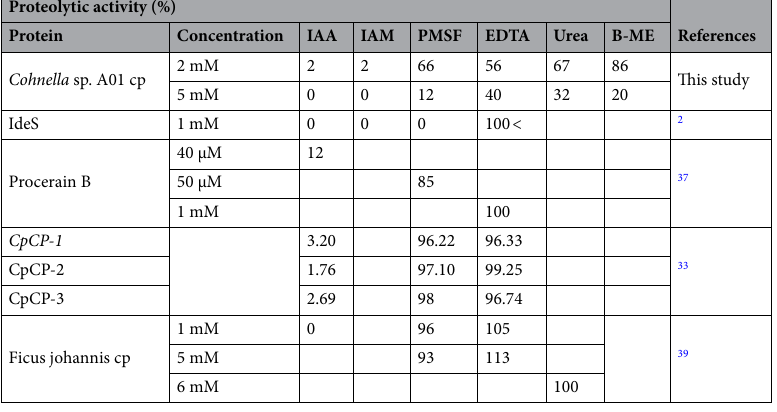
Table 3. Effect of inhibitors on rEla several characterized cysteine